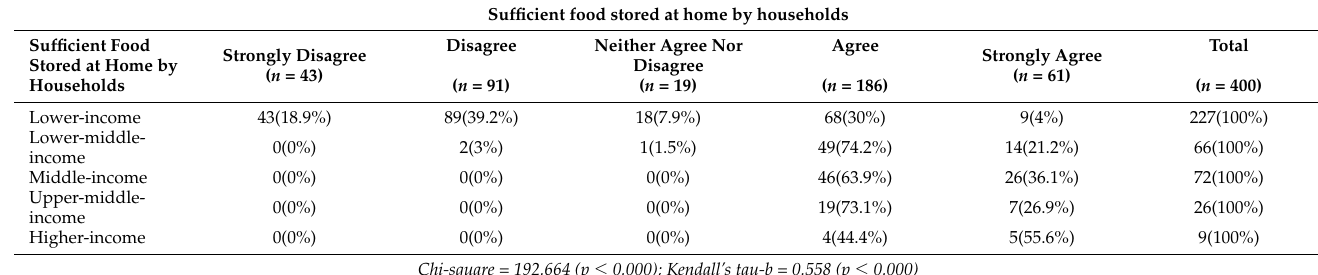
Table 8. The perception of respondents about food storage effect on household food security.